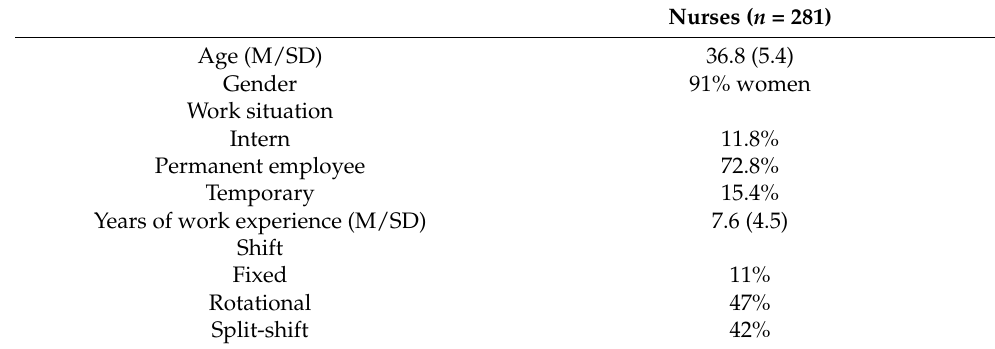
Table 1. Sociodemographic